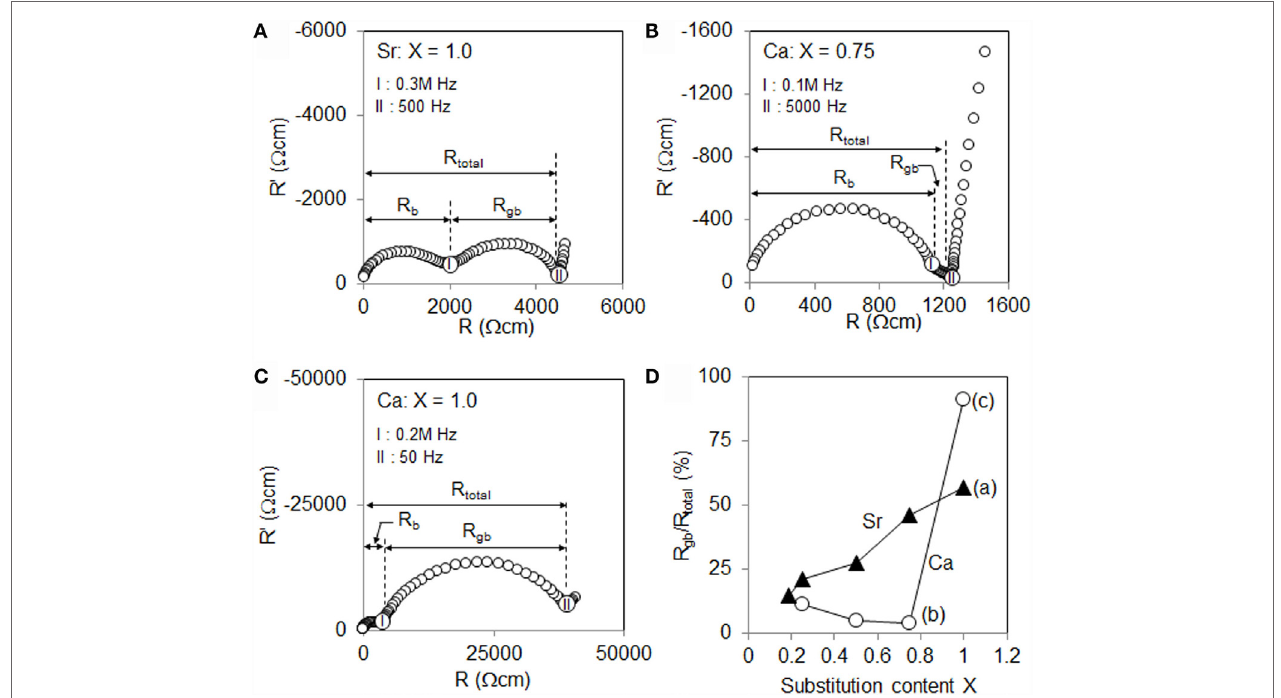
FigUre 1 | nyquist plots for li 7 + X − Y (la 3 − X a X )(Zr 2 − Y nb Y )O 12 (a-llZnb, a = sr or ca) in which (a) a = sr, X = 1.0, (B) a = ca, X = 0.75, (c) a = ca, X = 1.0, and (D) the ratios of resistance due to grain boundaries to total resistance (r gb /r total ) as functions of X . The terminal frequencies of both resistances are shown in the graph.